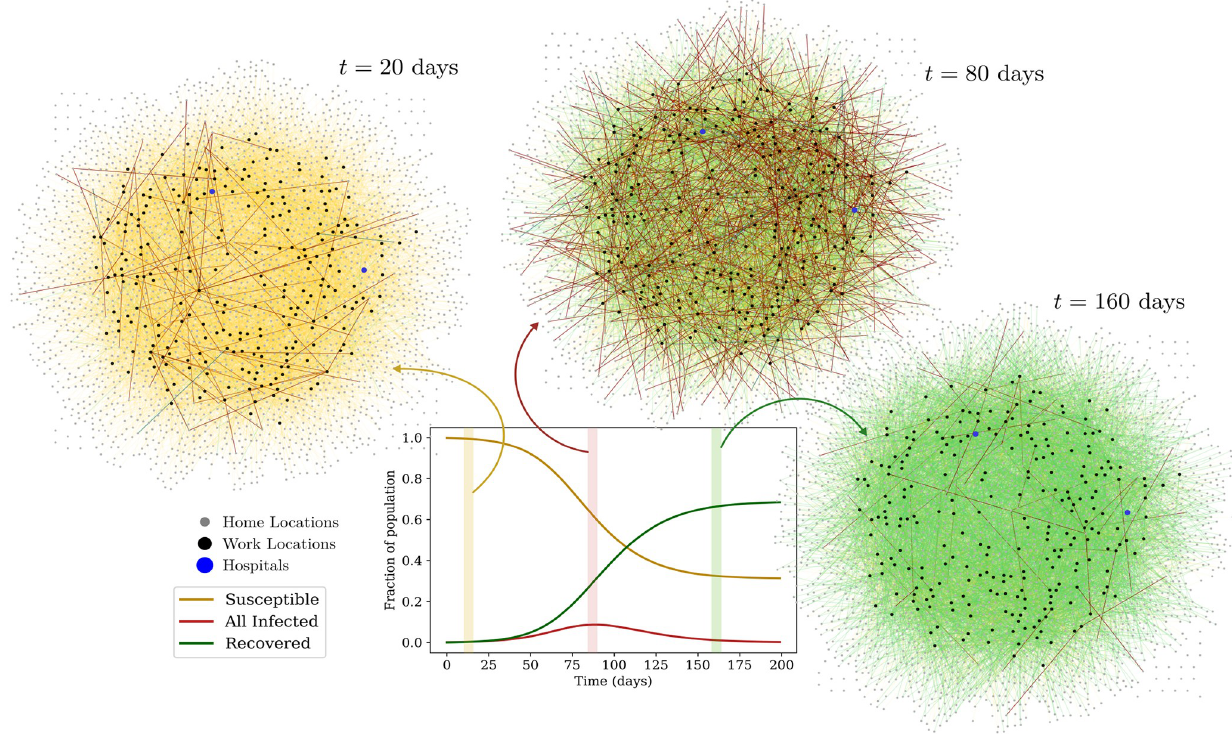
Fig 3. Visualization of the network. The plot shows the aggregate number of susceptible, infected ( A + P + SI + MI + H ) and recovered individuals across all locations as a function of time. In the three graphs, the nodes represent locations; the grey nodes are homes and the black nodes are work locations. Hospitals are represented by blue nodes. Individuals are represented by (undirected) links between a home and a work location. The color of these links represents their infection state: Yellow links represent susceptible individuals, while red links represent the infected across the infected compartments, and green links represent the recovered.